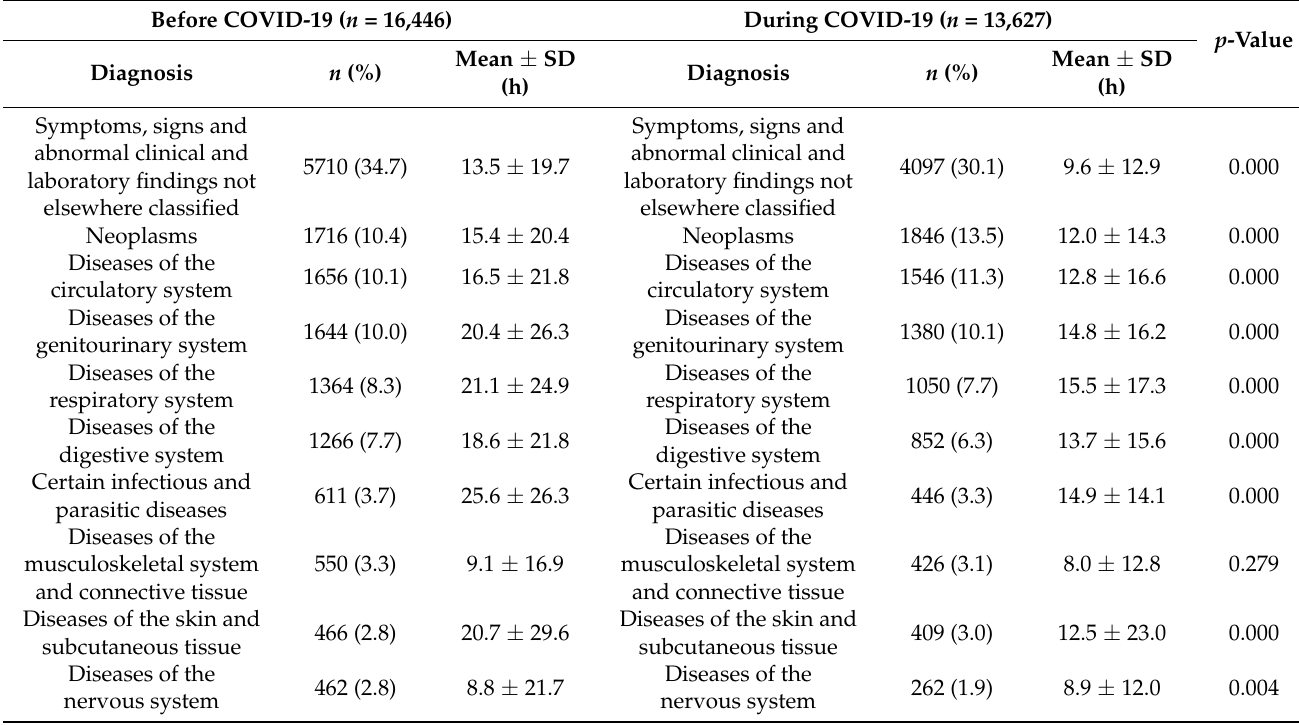
Table 4. Primary medical diagnoses (International Classification of Disease, 10th revision) of elderly patients and the length of stay in the emergency department (ED).